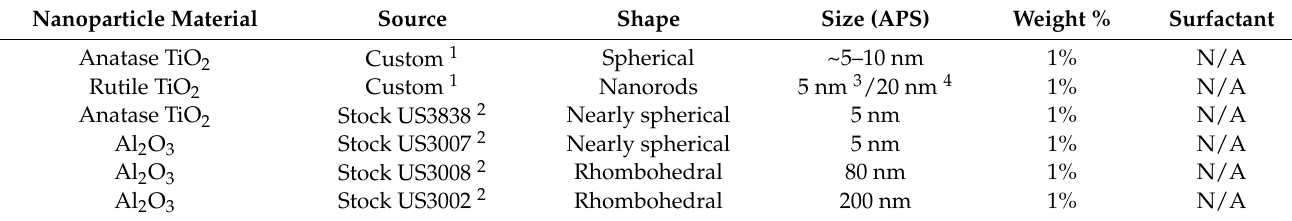
Table 1. Summary of nanoparticles.